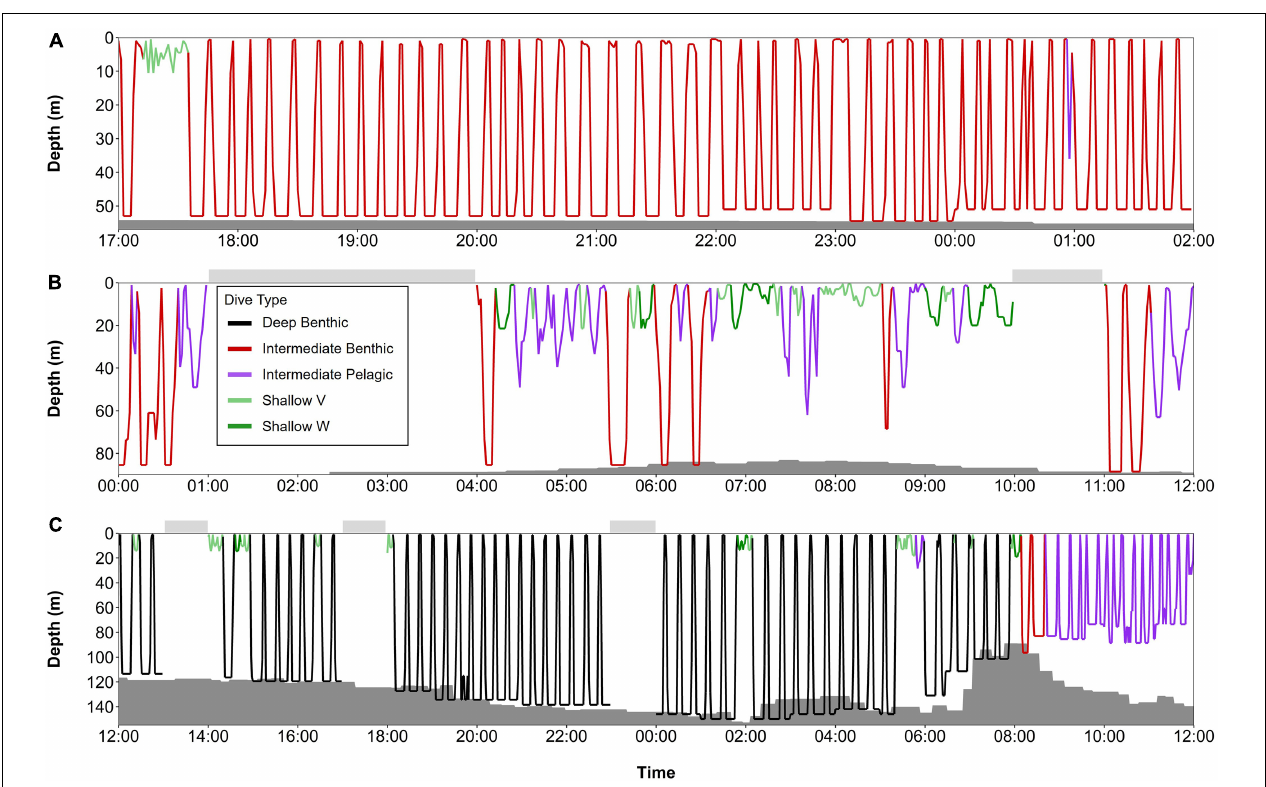
FIGURE 10 | Series of dives from late fall and spring, color-coded by dive type: (A) beluga LC2018#3 on 17th November 2018 (68.94 ◦ N, 171.82 ◦ W, Chukchi Sea) over a 9-h period, (B) beluga LC2018#6 on 21st March 2019 (63.48 ◦ N, 176.50 ◦ W, Bering Sea) over a 12-h period, and (C) beluga LC2018#2 on 17th May 2019 (71.48 ◦ N, 157.16 ◦ W, Barrow Canyon) over a 24-h period. Gray shaded areas denote seafloor depth; dive depth sometimes exceeds the estimated seafloor depth due to error in the bathymetric maps, CTCRW-modeled locations, and dive depth. Horizontal bars above each plot denote periods with missing data. All times in UTC. Note the different x and y axes scales used due to missing data in surrounding hours and/or to improve visualization of dive structure. Locations of dive profiles shown in Figure 1 .